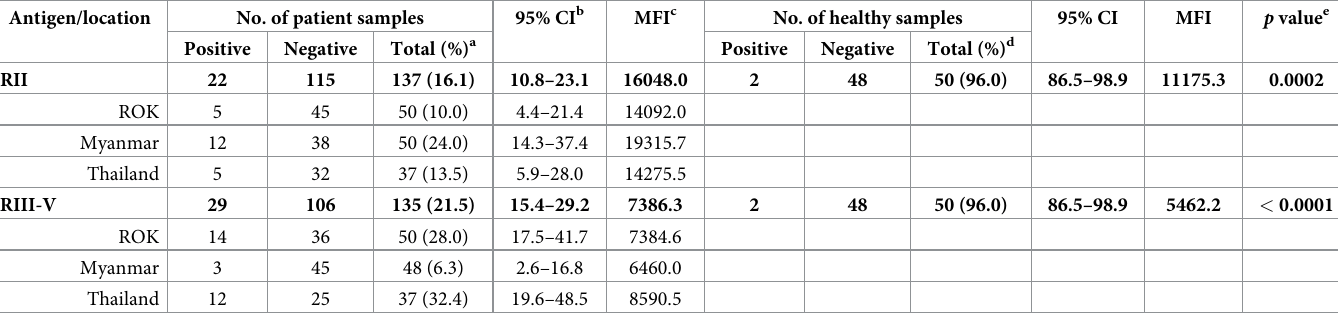
Table 3. Humoral immune responses of PvEBP-RII and -RIII-V domains.